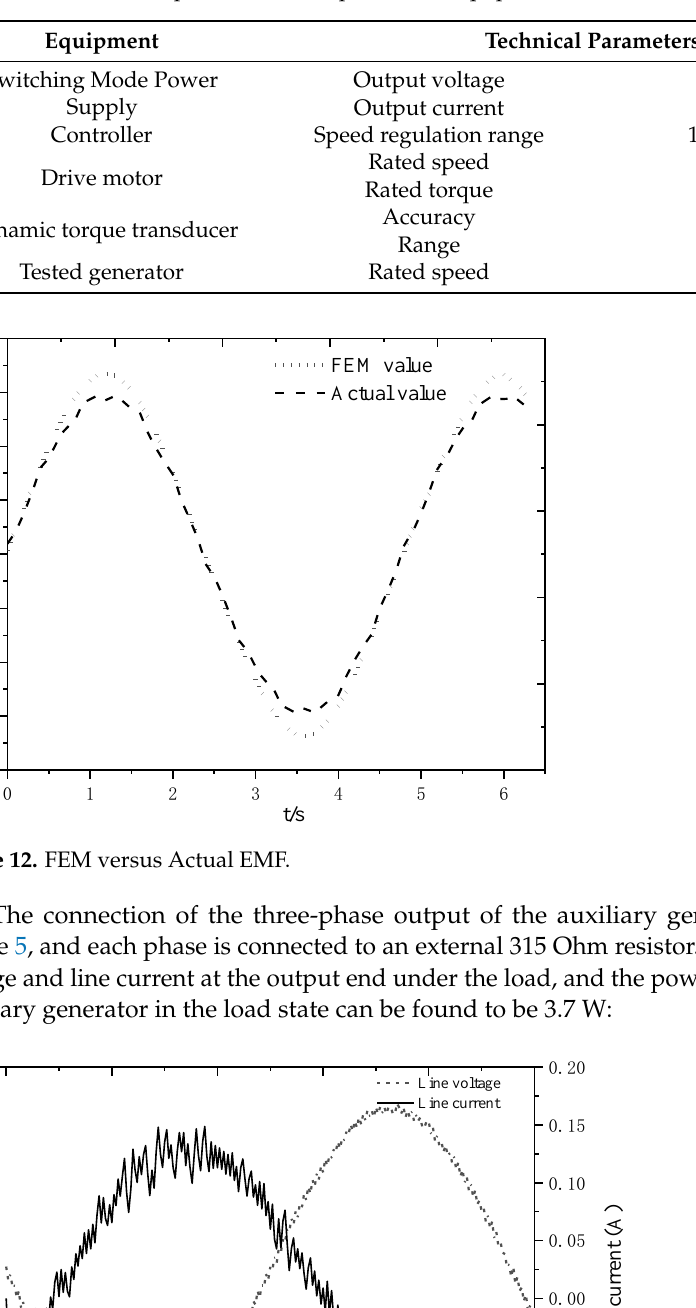
Table 9. Main technical parameters of experimental equipment.